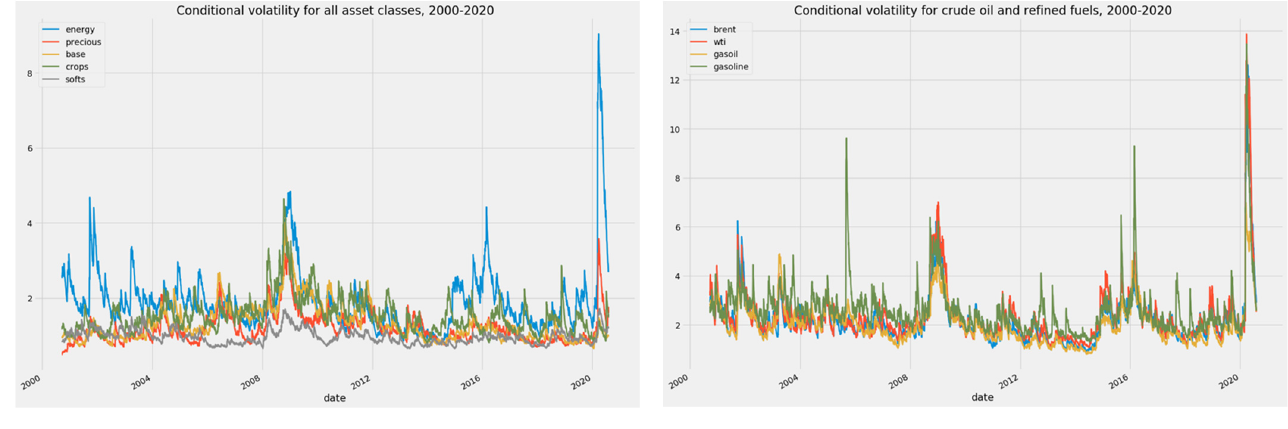
Figure 3. Conditional volatility forecasts: ( a ) All classes of commodities; ( b ) Crude oil and refined fuel markets.